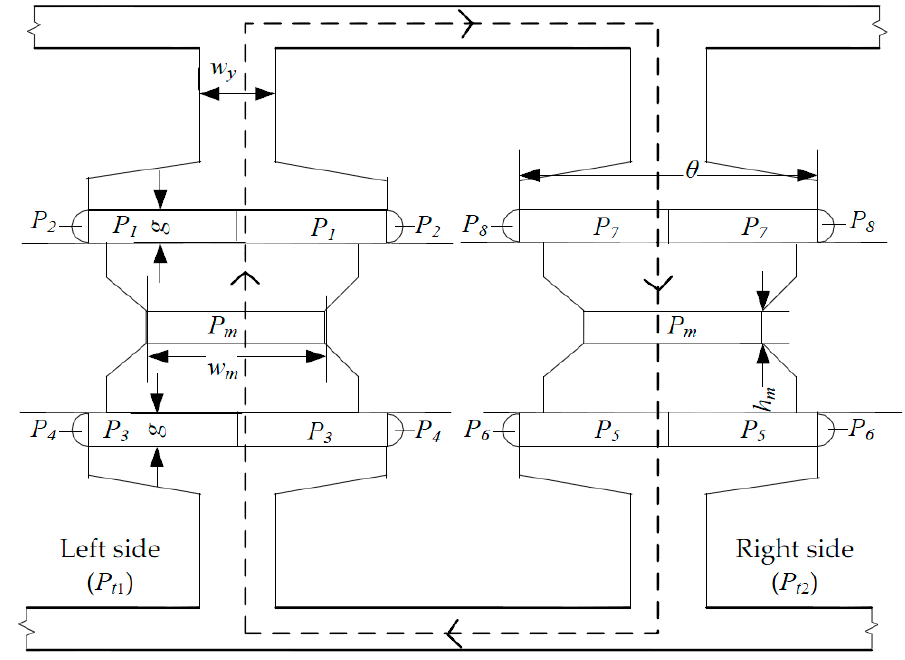
Figure 6. Flux flow of three phase DSSR-PMG.